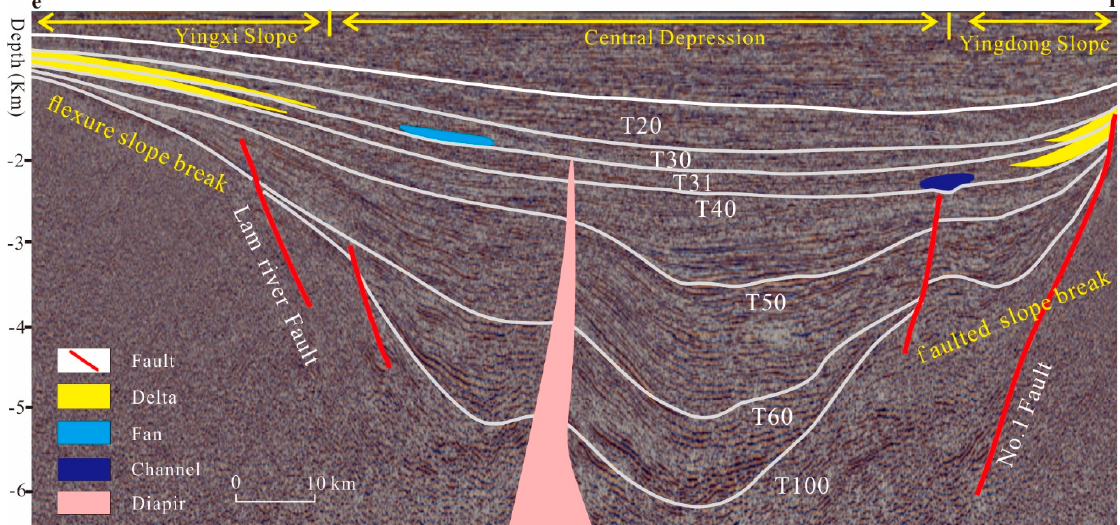
Figure 10. The flexure slope break zone was controlled by the Yingxi fault zone in the western margin of the basin, and the faulted slope break zone was controlled by the No. 1 Fault zone in the eastern margin of the basin (see the location of lines e-f in Figure 1).